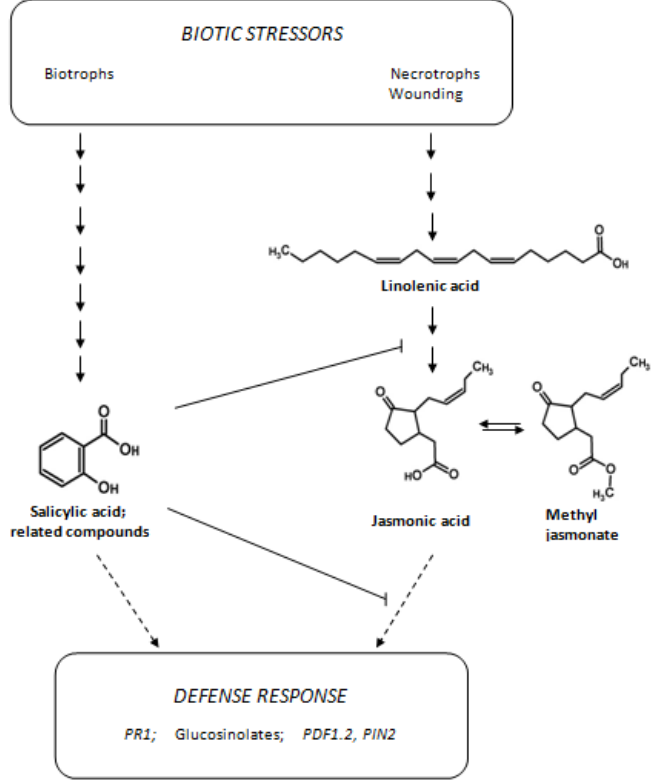
Figure 1. Signaling molecules involved in defense against biotic stressors. Investigated molecules are marked in bold. PR1 , PATHOGENESIS-RELATED 1; PDF1.2 , DEFENSIN-LIKE 16; PIN2 , PROTEINASE INHIBITOR